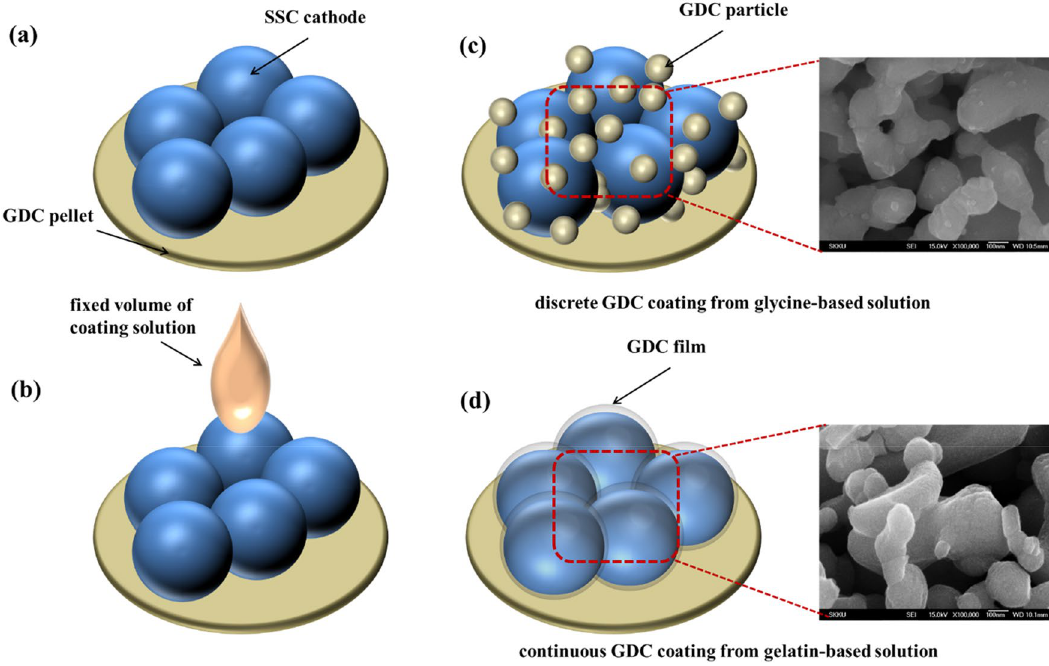
Figure 1. Overall process of surface coating onto the SSC cathode using infiltration process and the resultant SEM images of coated structure: ( a ) SSC particle scaffold on GDC pellet, ( b ) infusing GDC precursor